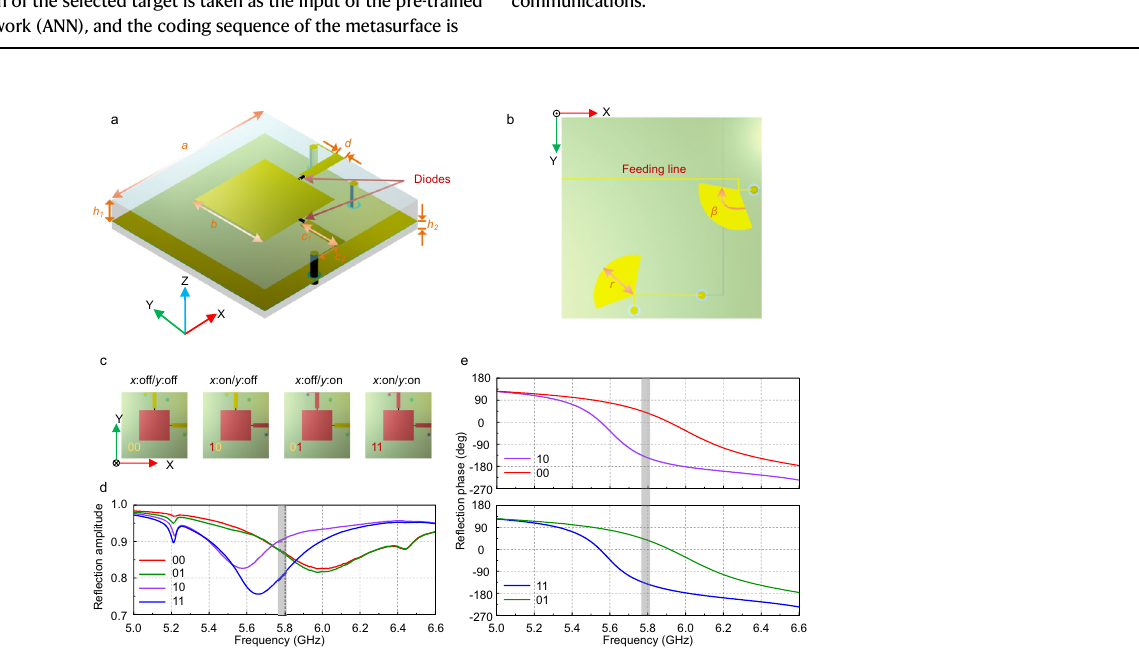
output in a few milliseconds, which is sent to the dual-polarized programmable metasurface through FPGA, thus realizing smart beam tracking and wireless communications.